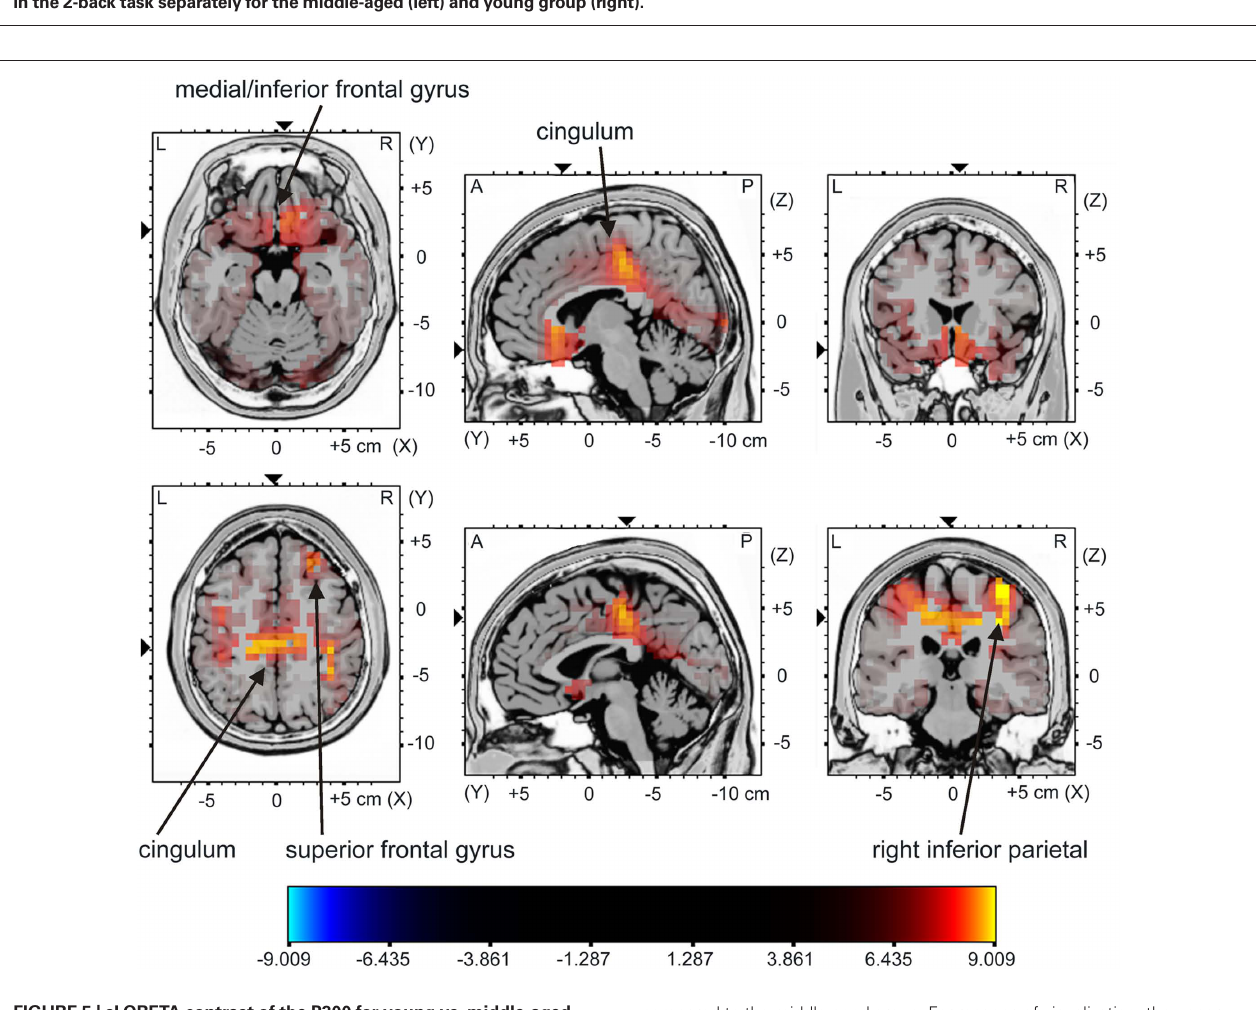
compared to the middle-aged group. For reasons of visualization, the upper panel shows sectional planes at ( x ; y ; z ) = ( − 6; 19; − 19) and the lower panel shows sectional planes at ( x ; y ; z ) = (2; − 30; 44). The main brain areas are labeled by